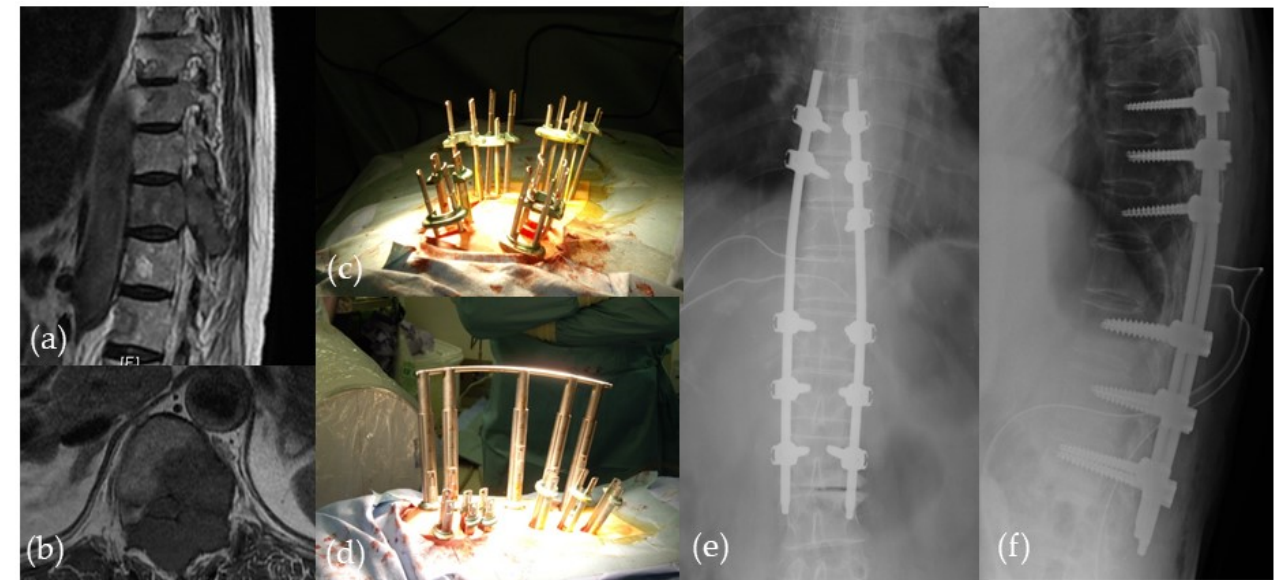
Figure 3. MIS-long fixation for spinal metastasis. ( a , b ) Preoperative MR images; ( c , d ) intraoperative images; ( e , f ) postoperative plain radiographs.